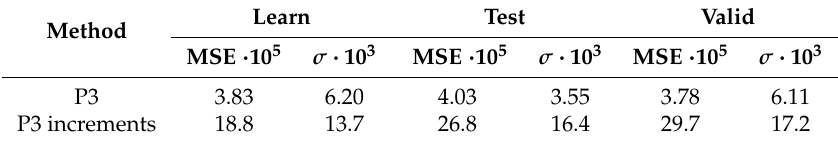
Table 5. Comparison of the learning, testing, and validation errors: P3 and P3 increments.